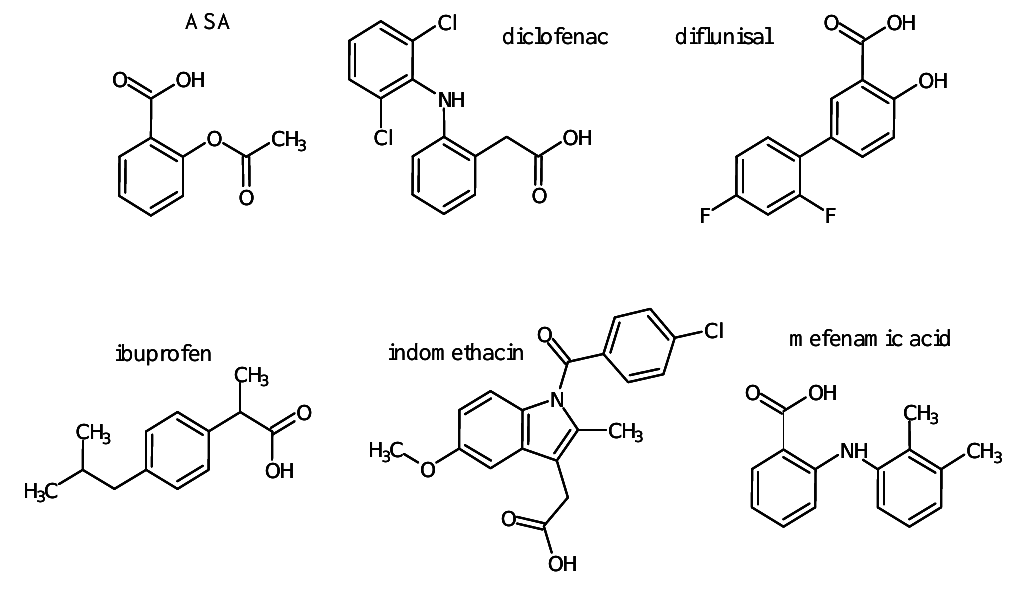
Figure 1. Chemical structure of NSAIDs used in this study.